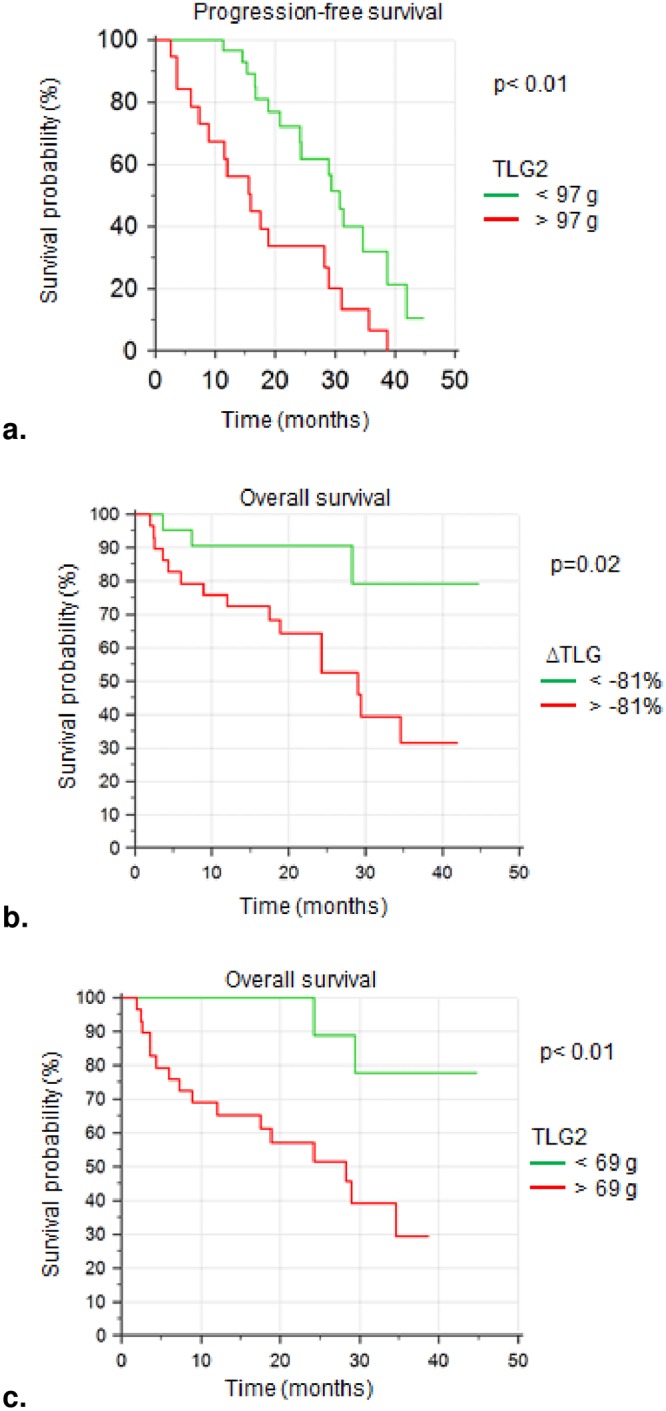
FDG PET parameters and survival curves.Survival curves using the Kaplan-Meier method. (a) PFS was longer for patients with low TLG2 (HR = 2.8, 95%CI 1.3–5.9, p< 0.01). After 2 years, the survival rate was 67% for the 30 patients with low TLG2 vs 34% for the 20 others. Median survival was respectively reached at 31 and 16 months. (b) 21 patients with high decrease of TLG after therapy (ΔTLG < -81%) showed longer OS (HR = 3.8, 95%CI 1.5–9.6, p = 0.02). After 1 year and after 2 years, survival rates for the 21 good responders were 91% versus 76% and 59% for the 29 bad responders. Median survival was not reached for good responders and was 29 months for the others. (c) Survival curves showed longer OS for patients with low TLG2 (HR = 7.1, 95%CI 2.8–18, p< 0.01). After 2 years, the survival rate was 89% for the 21 patients with low TLG2 (median survival not reached) vs 52% for the other 29 patients (median survival at 28 months).